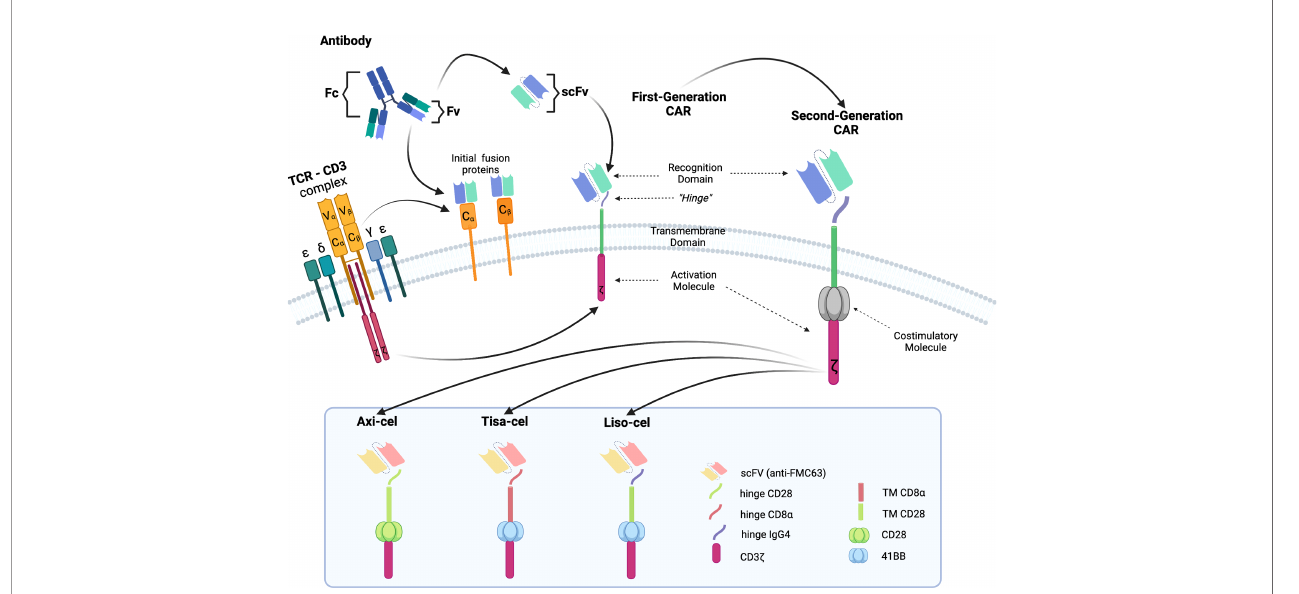
FIGURE 1 | Illustration of the evolution of chimeric receptors design. Fragments from the native TCR-CD3 complex and antibodies were joined into fusion proteins that were improved to reach the basic structure of the second-generation CARs, which were successfully brought to the clinic. At the bottom, the fi gure shows the critical differences between the three FDA-approved second-generation CAR